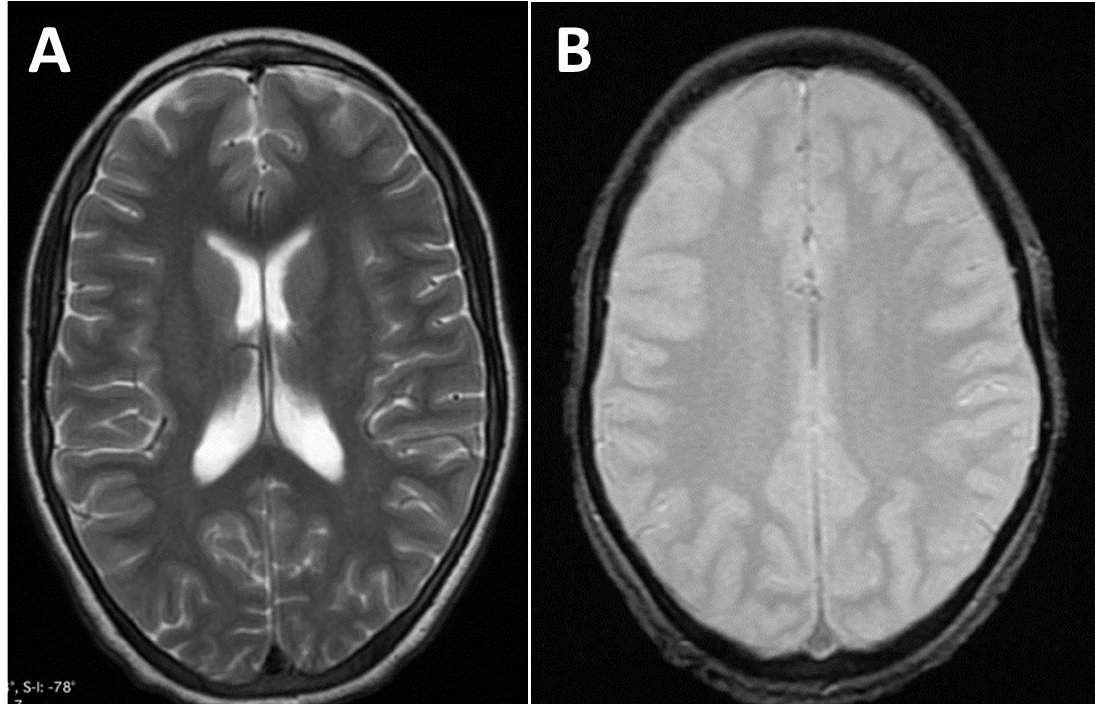
Figure 6. Brain mass without signs of deposit. A : Axial T2-weighted frFSE image. B : Axial T2-weighted GRE image.